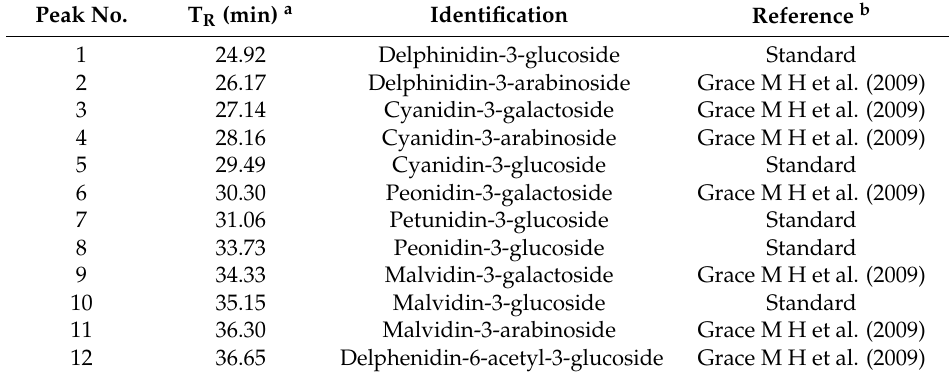
Table 2. Anthocyanin compounds identified from fruits of blueberry cultivars. Peak No.